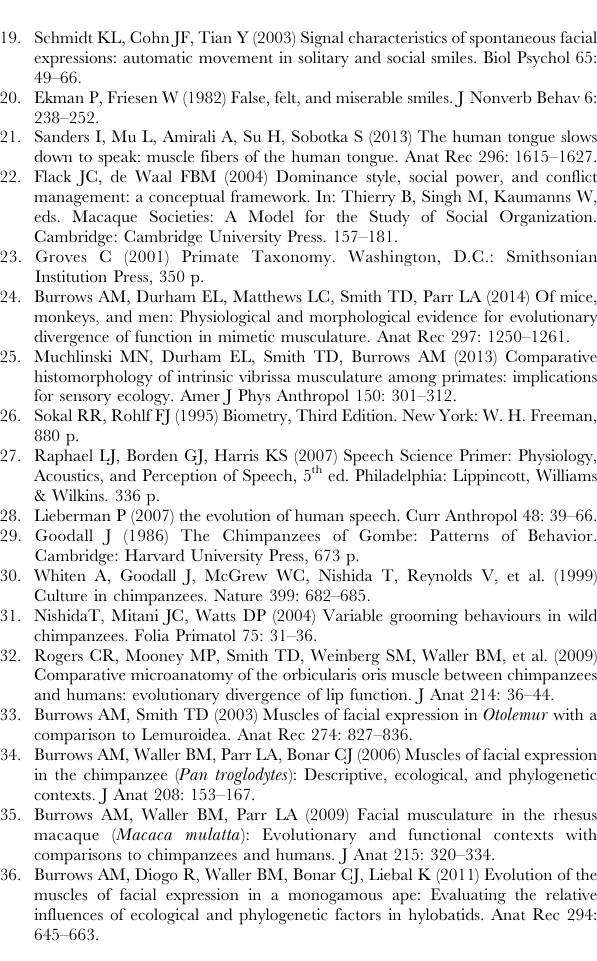
Table S2 Mean ( + standard error of the mean) percentages of slow-twitch myosin fibers by study group and muscle.